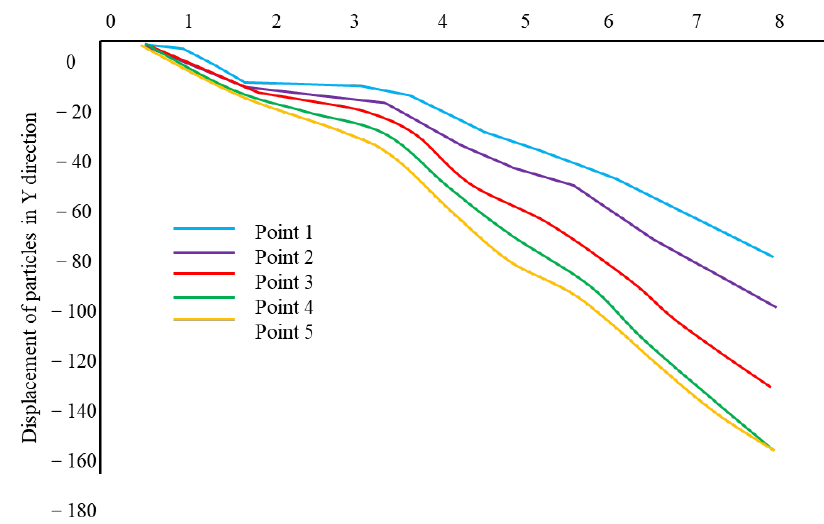
Figure 7. Part of the characteristic point y: direction displacement curve.